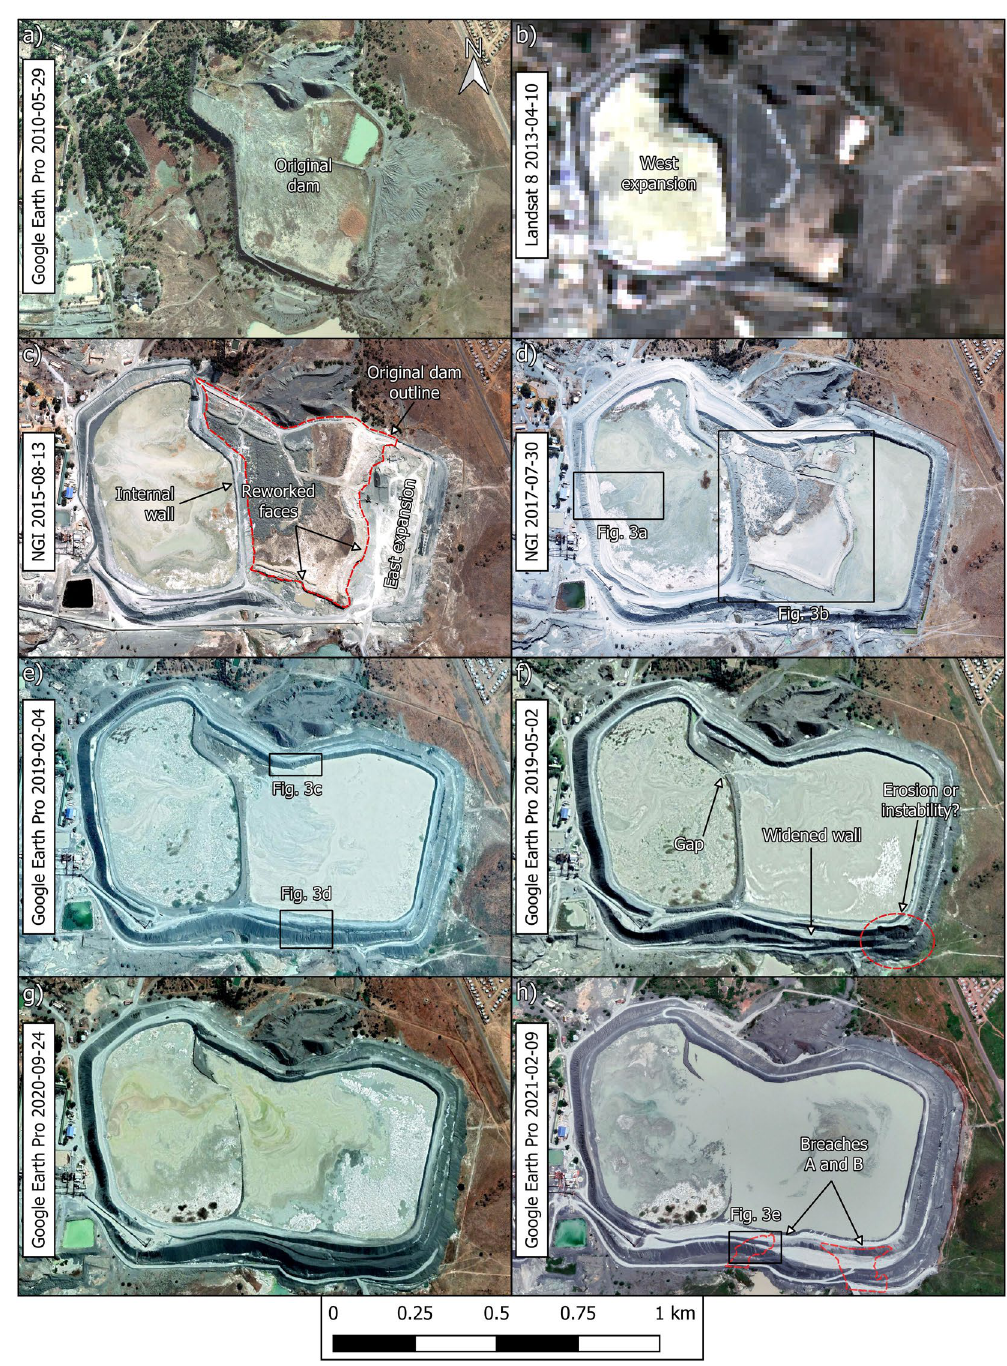
Figure 2. Historical imagery of the Jagersfontein dam. ( a ) Configuration prior to reprocessing of legacy mine waste. ( b ) West expansion is visible by April 2013. ( c ) Deposition in the west expansion concurrent with reworking of the original dam and activity in the east expansion. ( d ) Furrows are visible by July 2017. ( e – g ) Eastward migration of tailings from the west expansion through a gap in the internal wall in 2019 and 2020. ( h ) Internal wall is almost entirely buried. NB: Part ( h ) shows location of breaches A and B which developed during failure (Fig. 5). Created using QGIS software version 3.26 (http:// www. QGIS.